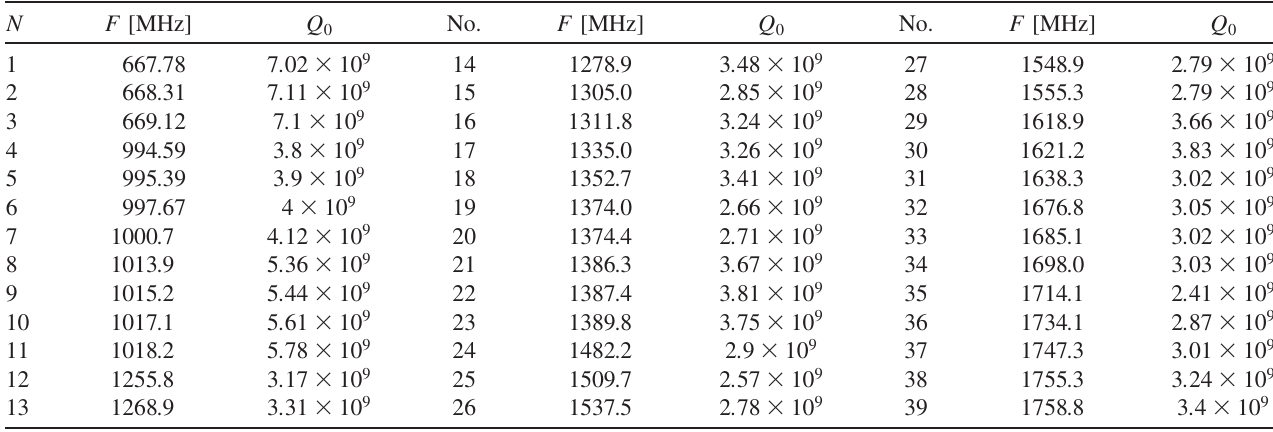
TABLE III. Performance of TE onm -type HOMs of the LEP cavity applicable for rf